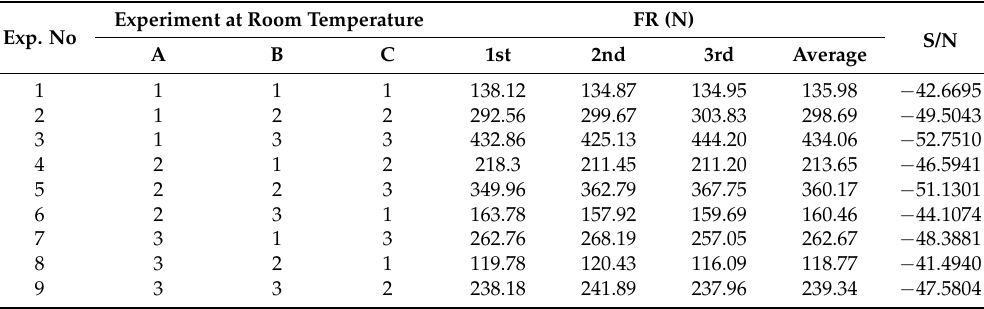
Table 6. Results of cutting force (FR) and S/N ratios at room temperature.